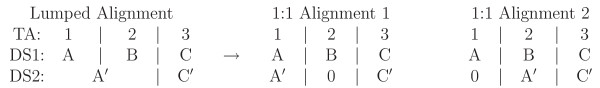
Example of a lumped MicroMerge alignment and its corresponding one-to-one alignments, where TA = theoretical alleles, DS1 = data set 1 bins, and DS2 = data set 2 bins.